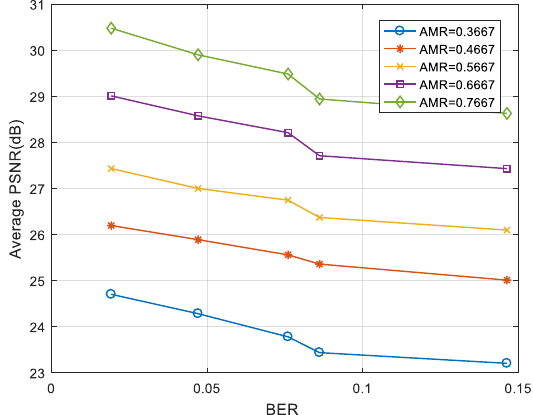
Figure 14. BER-PSNR performances for the “coastguard”.